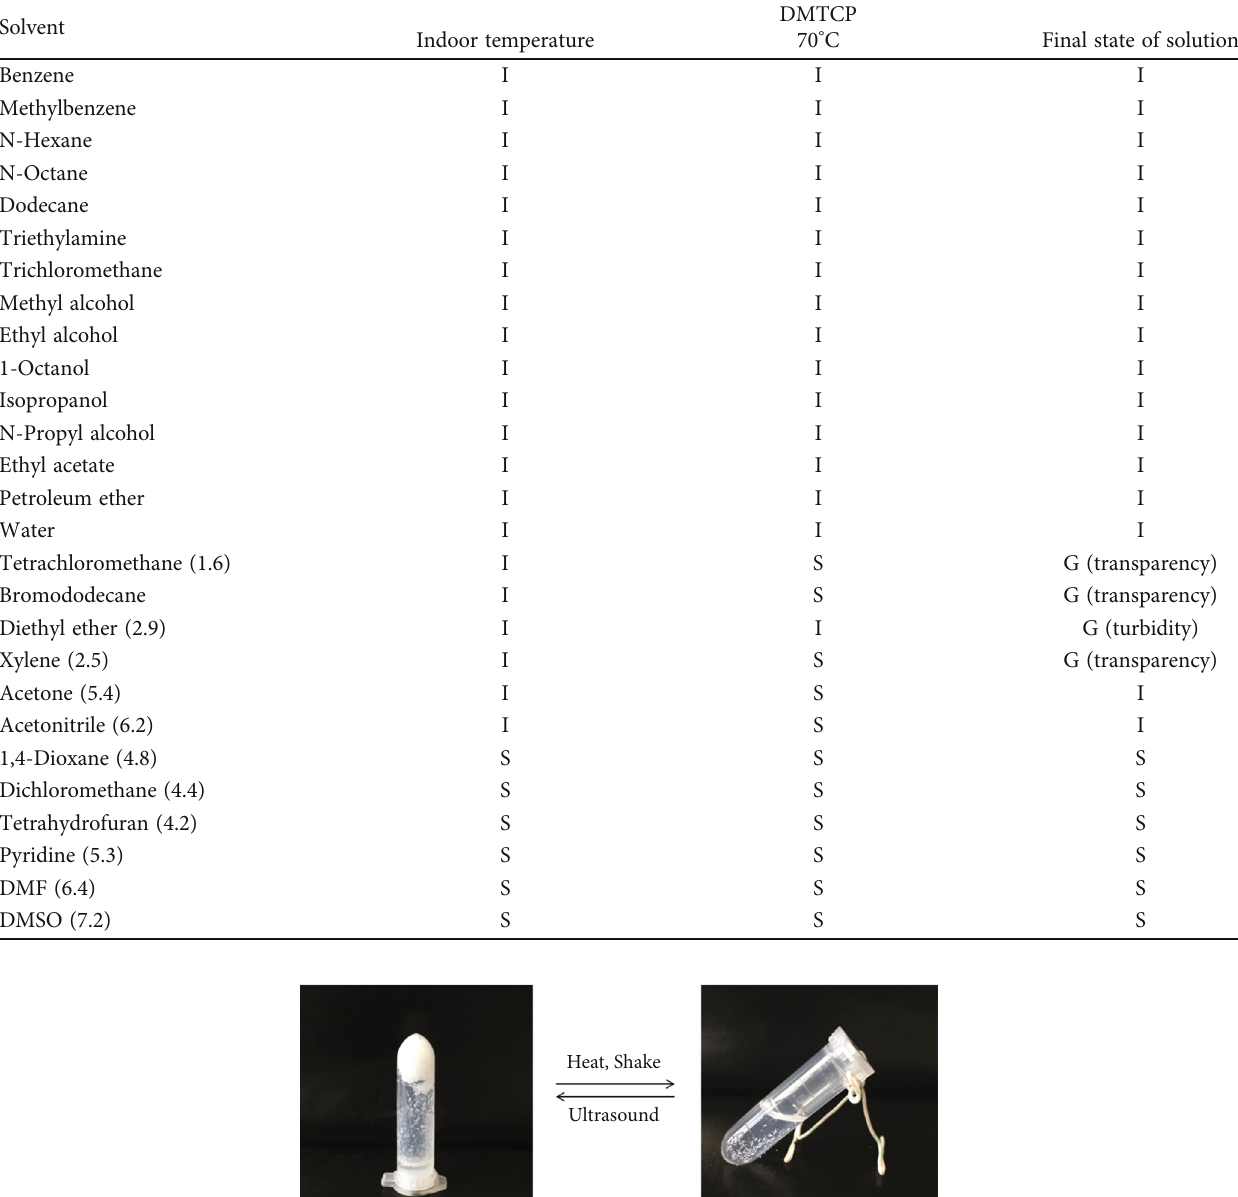
Table 11: Gelation behavior of DMTCP in di ff erent organic solvents.